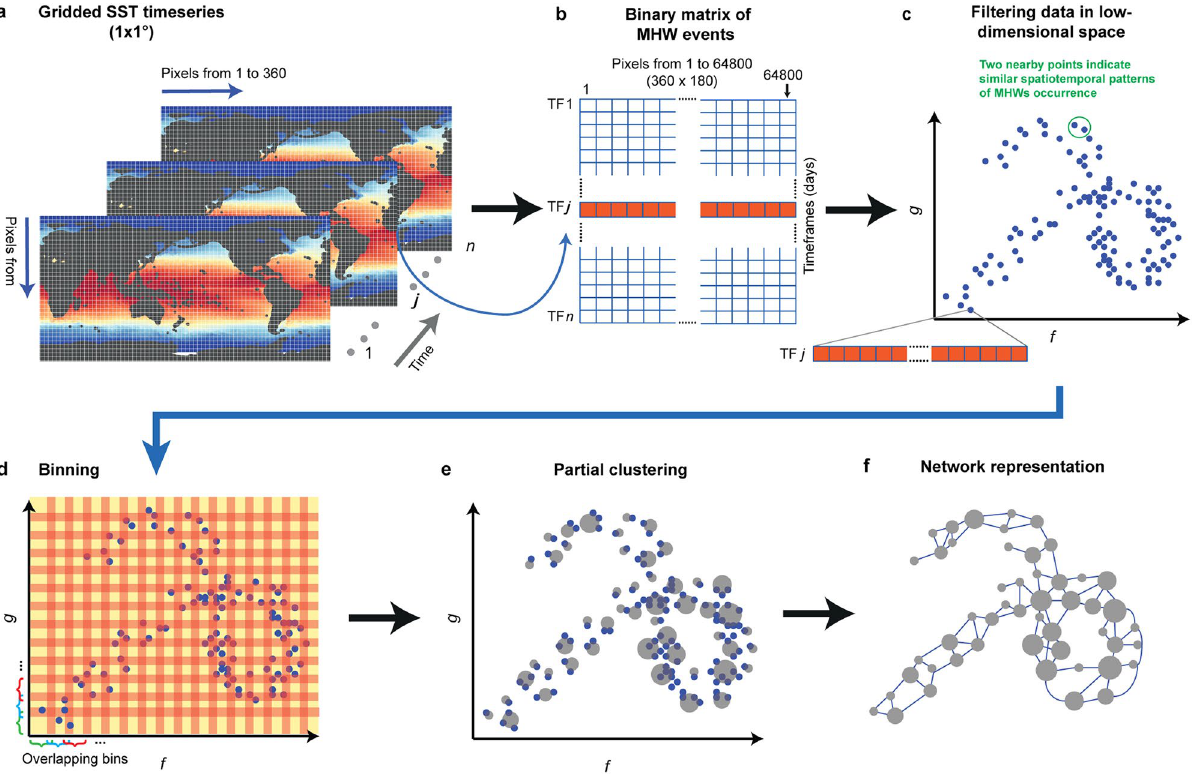
Figure 1. Workflow to reveal the dynamical organization of marine heatwaves (MHWs) using Mapper. ( a ) Raster stacks of daily sea-surface-temperature (SST) timeseries at 1° × 1° resolution. There is one raster stack for observed SSTs and one for each of the simulated emission scenarios (Historical, RCP 2.6 and RCP 8.5). MHWs are identified and characterized from SST timeseries for each pixel in each raster stack using the definition proposed by Hobday et al. 27 . Maps were produced in R 4.0.2 29 (https ://www.R-proje ct.org/). ( b ) Each raster stack is collapsed into a binary 2D matrix where rows are timeframes (TF) and columns are 1° × 1° cells arranged sequentially to represent the occurrence of MHWs across the global ocean. Data entries in the matrix indicate the absence (zero) or the occurrence (one) of an MHW for a given day and pixel. ( c ) Filtering step or non-linear dimensionality reduction, where MHW occurrence data is projected into a lower two-dimensional space (represented by dimensions g and f ). ( d ) Binning step where the low-dimensional space is divided into overlapping bins whose size is determined by the resolution parameter R and degree of overlap is determined by the gain parameter G . ( e ) Partial clustering of timeframes within nodes to obtain a compressed representation of the original data. Each node contains from one to several timeframes with similar spatial patterns of MHW occurrence. The size of each node reflects the number of timeframes included in the cluster. ( f ) Final representation of an MHW network. Nodes that share at least one timeframe are connected through an